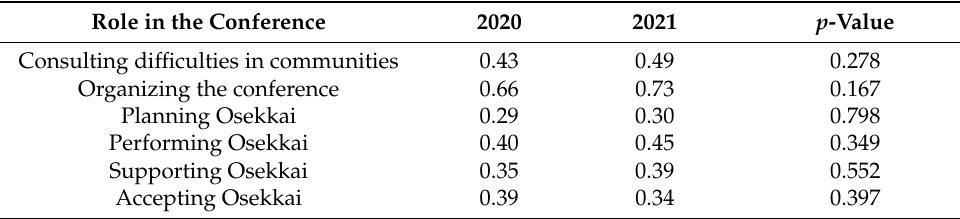
Table 2. Change in the role of Osekkai conferences during the study period. Role in the Conference